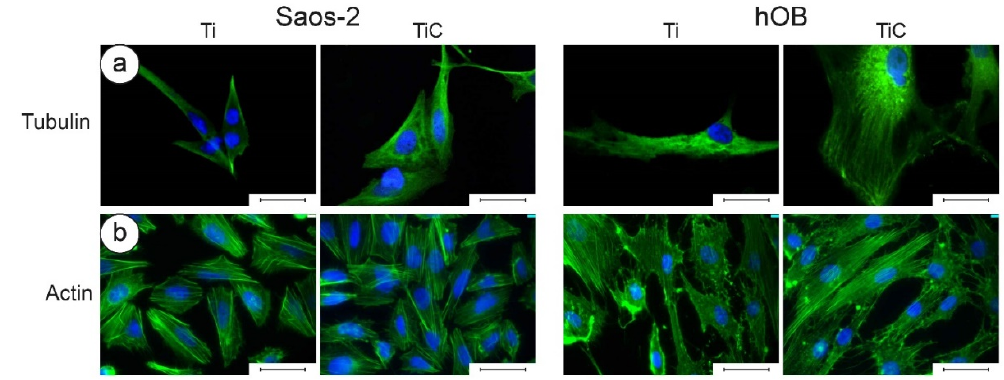
Figure 7. Immunofluorescence images of tubulin and actin in Saos-2 cells and in human primary osteoblasts. Panel ( a ): The Saos-2 (left panels) and the hOB cells (right panels) were grown for 96 h on glass slides coated with 10.5 nm of titanium or the nanostructured TiC layer, treated with primary monoclonal antibodies against tubulin (tubulin mouse monoclonal antibody 10 µg/mL) and Alexa Fluor 568 goat anti-mouse secondary antibodies, diluted 1:500. Panel ( b ): The cells were treated with Phalloidyn Alexa Fluor 488-conjugated, diluted 1:10. In all images, the nuclei were stained with DAPI. The images were collected with a magnification of 63×, and the bar represents 100 µm. Obtained with permission from [64] . Copyright (2016), with permission from PLoS ONE.